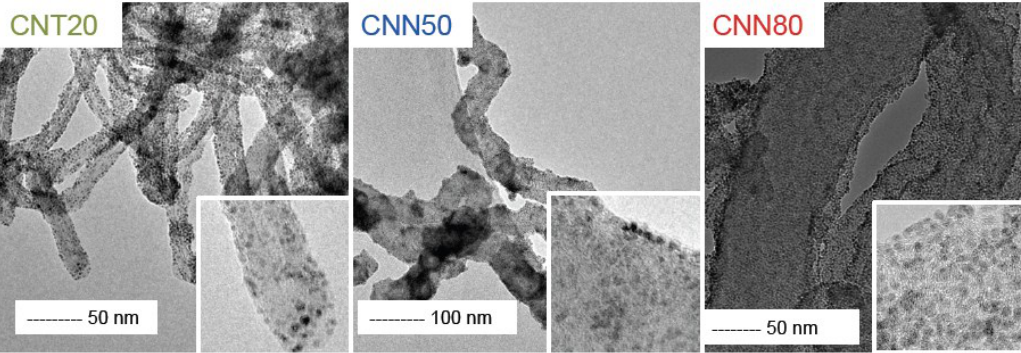
Figure 3. TEM images of the synthetized